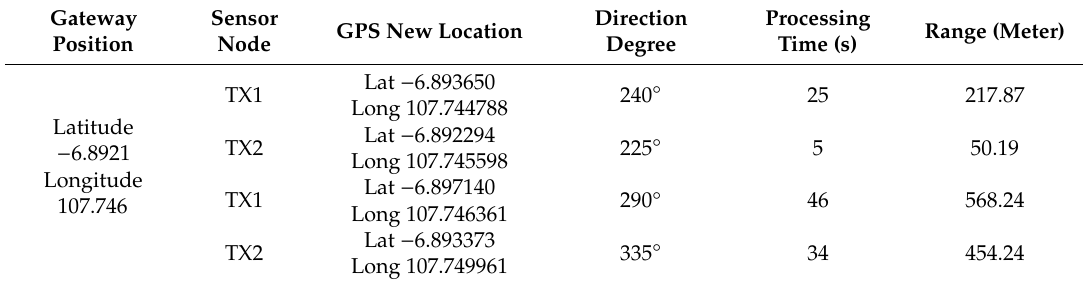
Table 4. Test Result Tracking of Proposed System at N-LoS Suburb Forest Location.